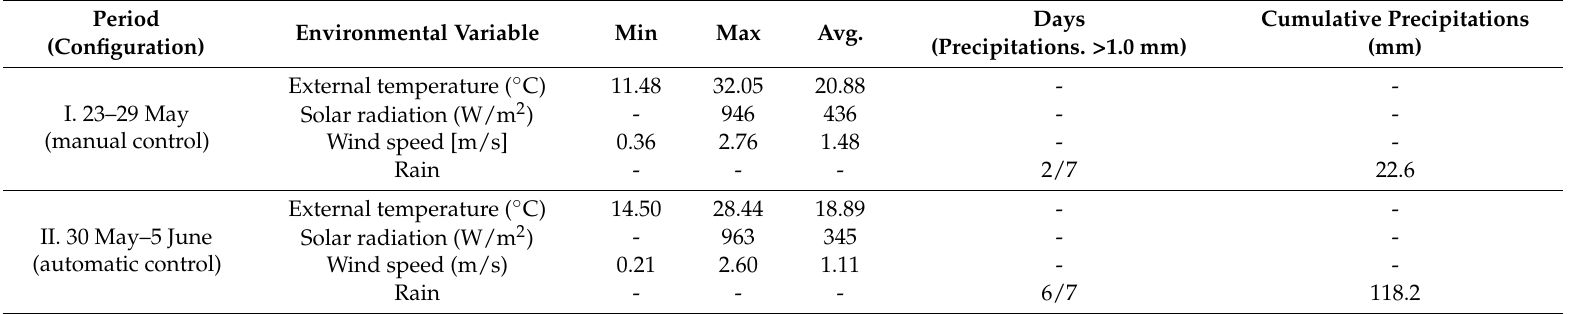
Table 3. Weather data for the two configurations—external temperature, solar radiation (the period of diurnal average of solar radiation is from 8 a.m. to 9 p.m.), wind speed,